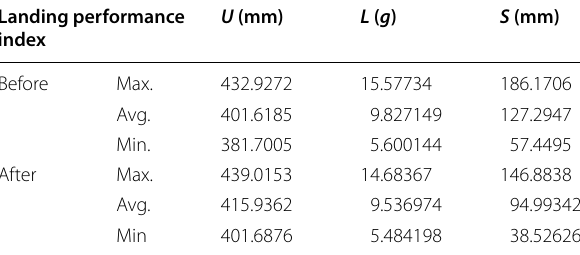
Table 10 Results of the hierarchical optimization Landing performance index